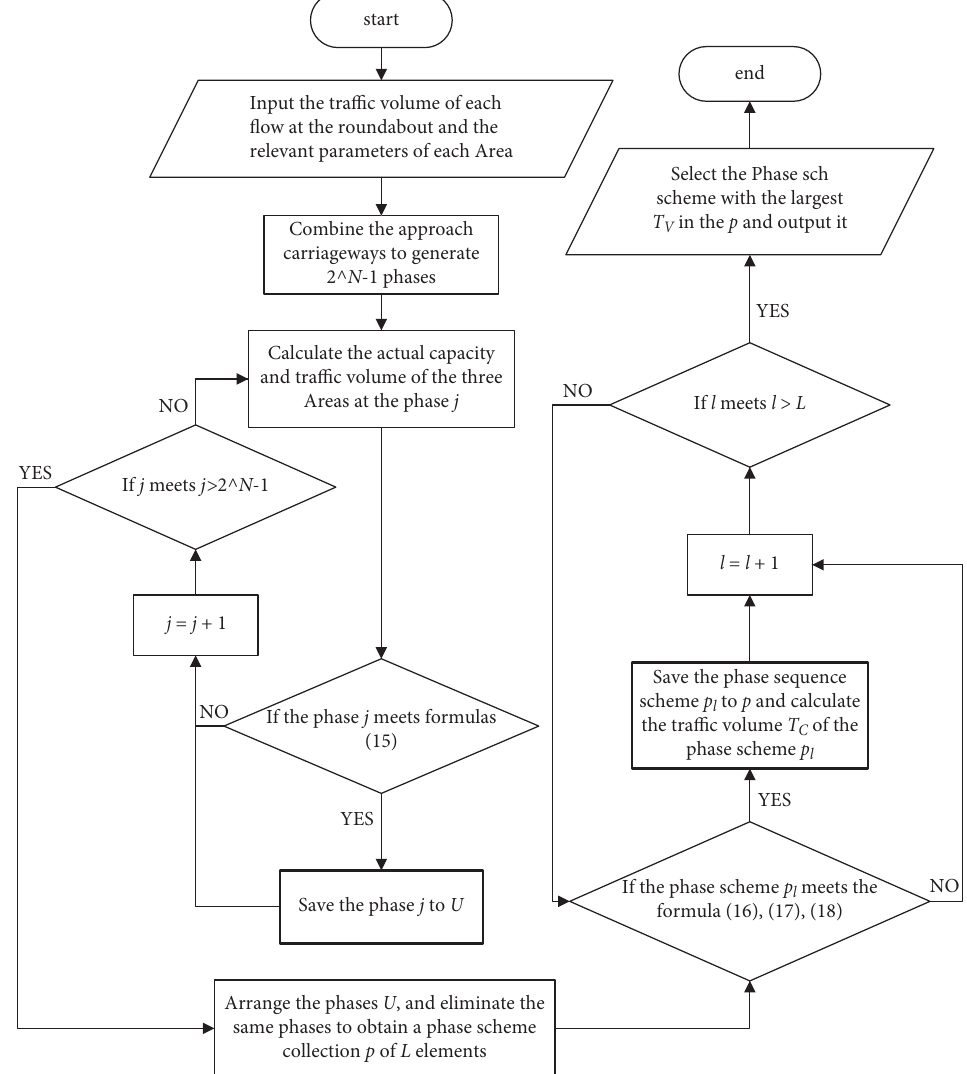
Figure 2: Programming fow chart of the combined phase design